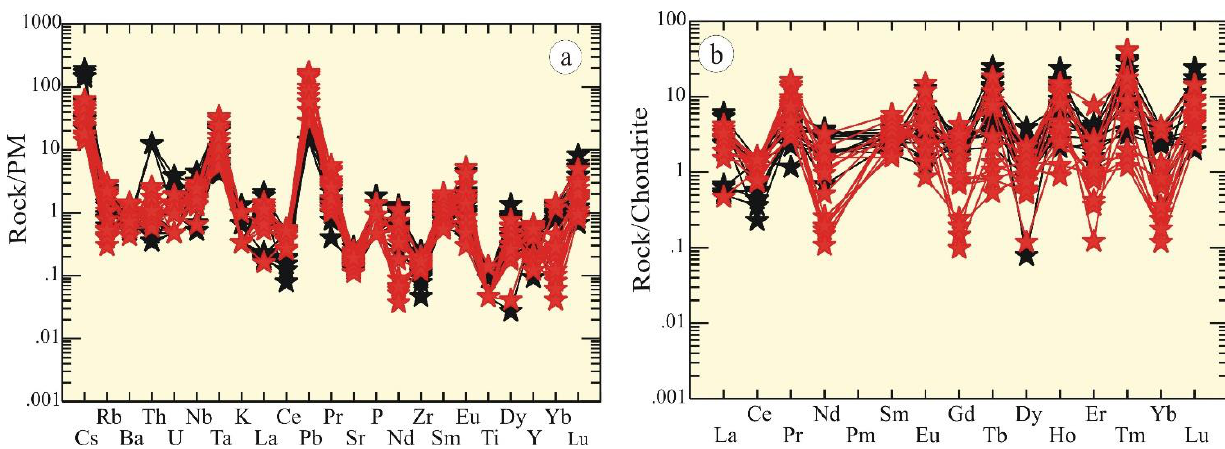
Figure 9. ( a ) Trace elements of the examined ultramafics normalized to the primitive mantle; and ( b ) chondrite-normalized rare earth elements [51].